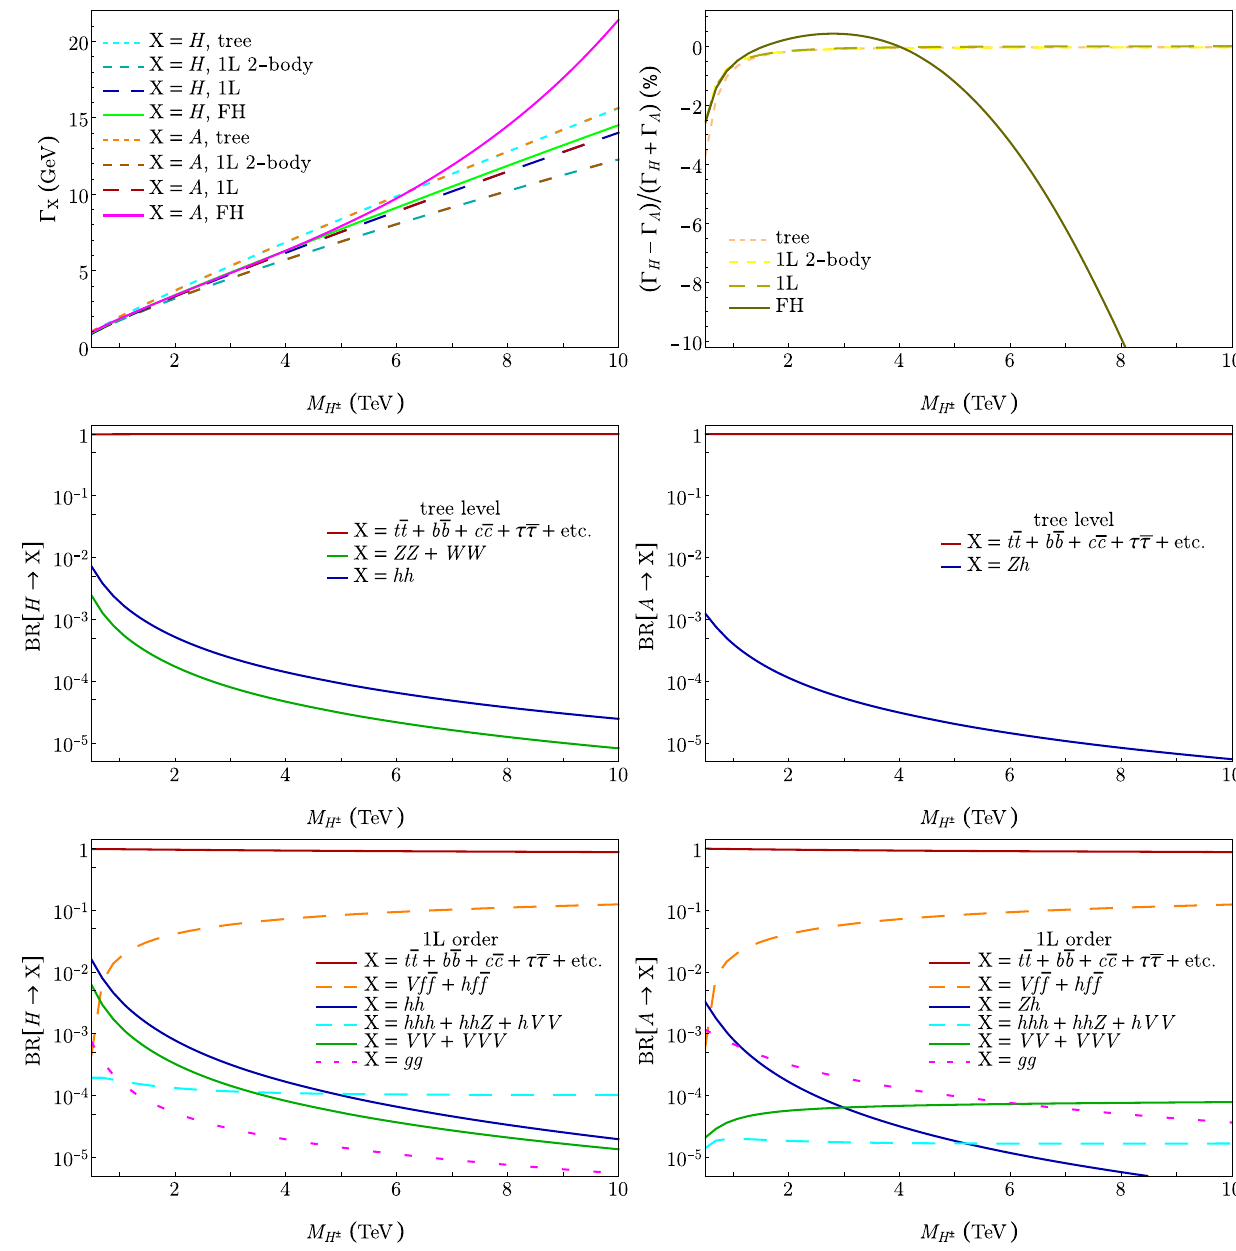
Fig. 3 Total widths, magnitude of SU ( 2 ) L -breaking, and branching ratios of the neutral heavy Higgs bosons at t β = 10 for the MSSM with a decoupled SUSY sector. Top Left: Total widths at (QCD+QED- corrected)treelevel(short-dashedcurves),full1L(long-dashedcurves) and pseudo-widths (sum of 1L-corrected two-body widths; in interme- diate dashes). The predictions of FeynHiggs are shown as solid lines. Top Right: Magnitude that SU ( 2 ) L -breaking reaches at the level of the